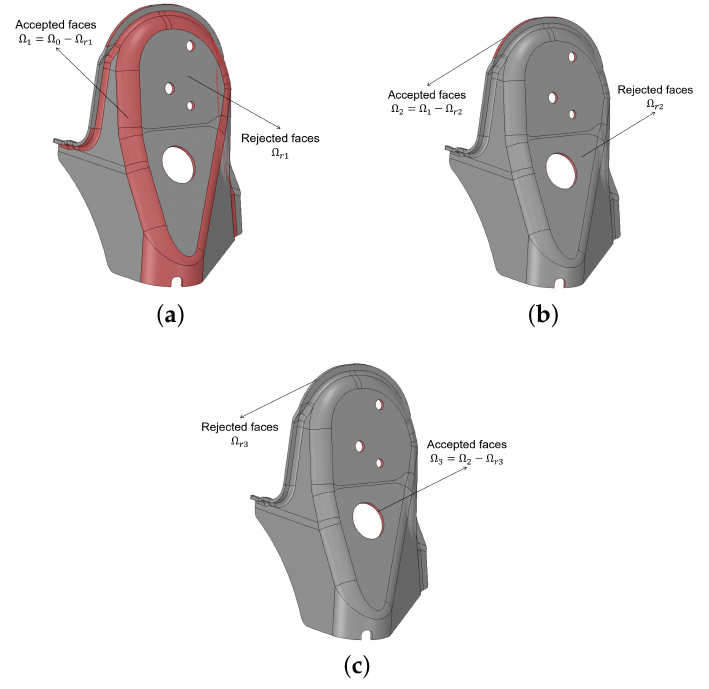
Figure 15. Results of Example 2: recognition of hole feature in data set 2. ( a ) Reduced domain Ω 1 ⊂ Ω 0 , ( b ) Reduced domain Ω 2 ⊂ Ω 1 , and ( c ) Reduced domain Ω 3 ⊂ Ω 2